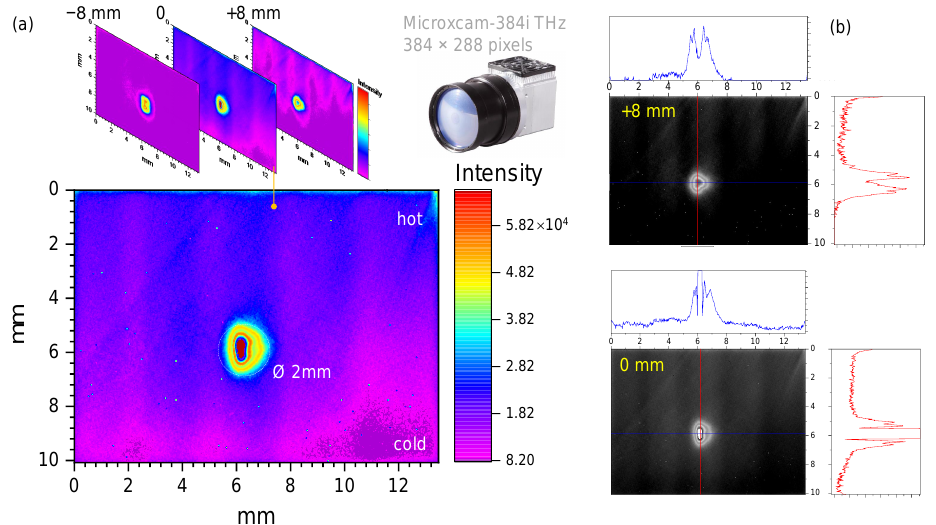
Figure A2. ( a ) Visualisation of THz beam at the focal region without spectral nor polarisation discrimination (8-bit Microxcam-384i camera). ( b ) Central cross sections at 0 and 8 mm positions are shown on the right-side plots. Beam diameter at the focus was ∼ 2 mm; saturation at the central 0.5 mm spot was present at the recording conditions (old 1st